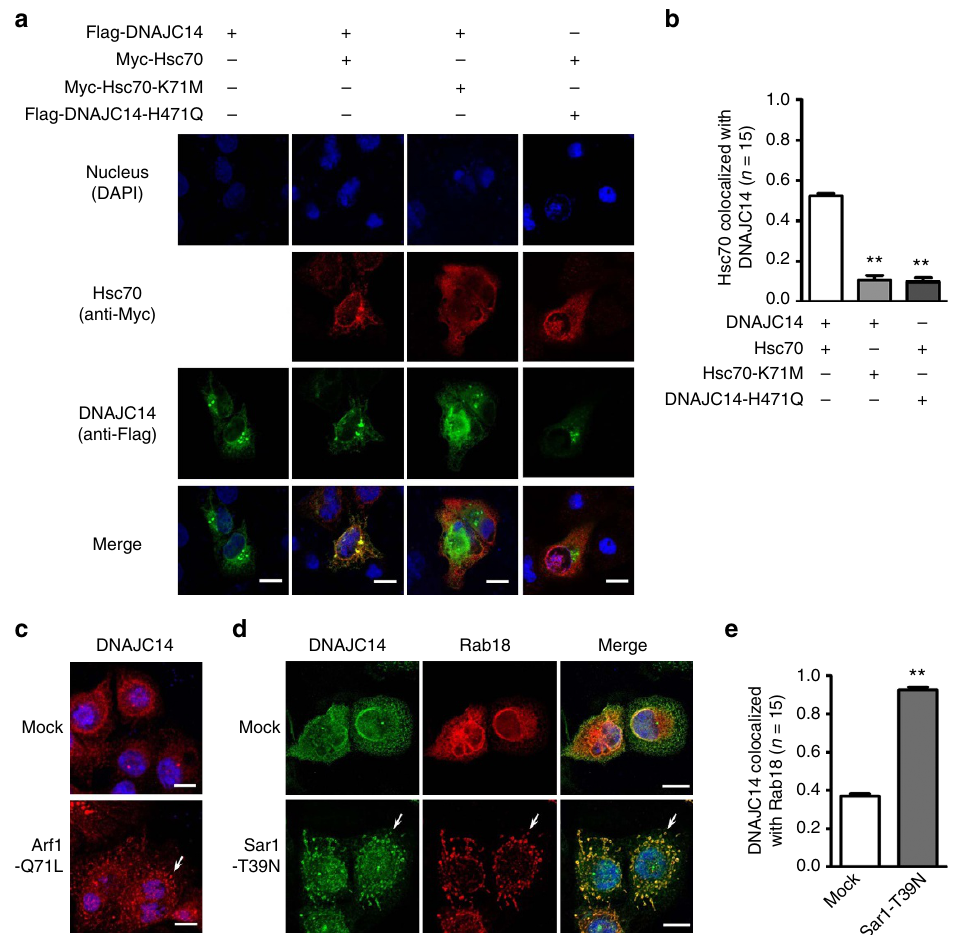
Figure 10 | Localization of DNAJC14 and Hsc70 in PANC-1 cells. ( a , b ) Subcellular localization of Flag-DNAJC14 and Myc-Hsc70 was examined in permeabilized PANC-1 cells. Representative images are shown in a . Quantitation of results from multiple experiments is summarized in b . A high degree of colocalization (an average of 52%) was observed in cells stained doubly with Hsc70 and DNAJC14. The Hsc70-K71M and DNAJC14-H471Q mutations significantly reduced colocalization of Hsc70 and DNAJC14. Scale bar, 20 m m. ** P o 0.01 by one-way analysis of variance, difference from lane 1, n ¼ 15. ( c – e ) Endogenous DNAJC14 and Rab18 in PANC-1 cells were immunostained. ER-to-Golgi blockade by Arf1-Q71L ( c ) or Sar1-T39N ( d ) induced the movement of endogenous DNAJC14 into punctate structures and increased colocalization with Rab18 ( d , e ). Scale bar, 20 m m. ** P o 0.01 by paired Student’s t -test, n ¼